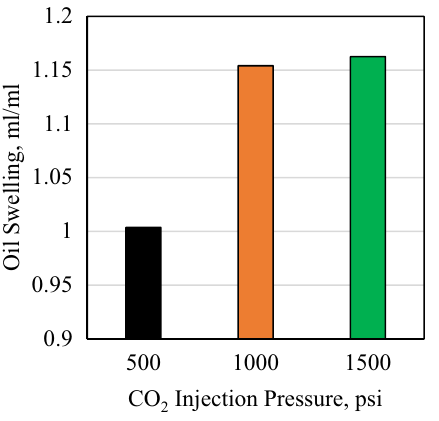
Fig. 3 Effect of temperature on oil swelling at 1500 psi using 1 ml